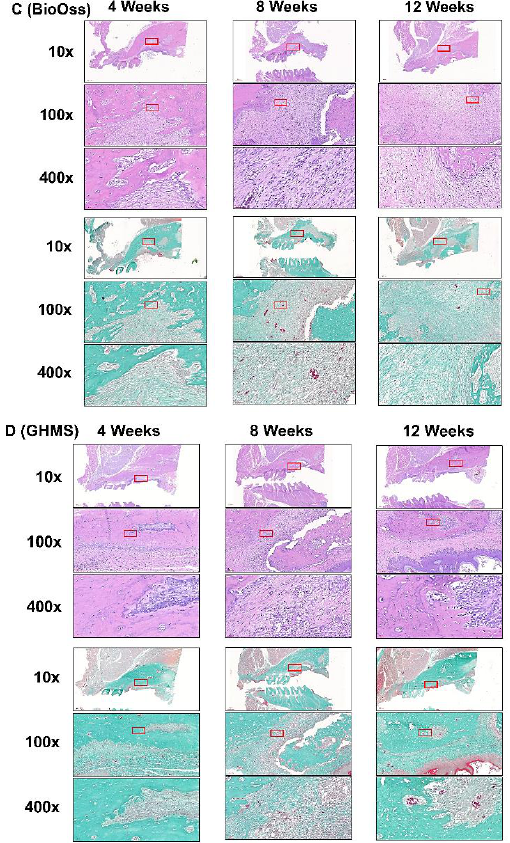
Figure 4. Representative histological sections of the maxillary first molar (M1) to third molar (M3) region of rats after M1 ( A ) extraction or grafting with ( B ) Sinbone, ( C ) Bio-Oss Collagen ® , or ( D ) gelatin/nano-hydroxyapatite/metformin (GHMS) by hematoxylin and eosin (H&E) and Goldner ’ s Trichrome staining at 4, 8, and 12 weeks. At the 12th week after extraction, new bone growth was